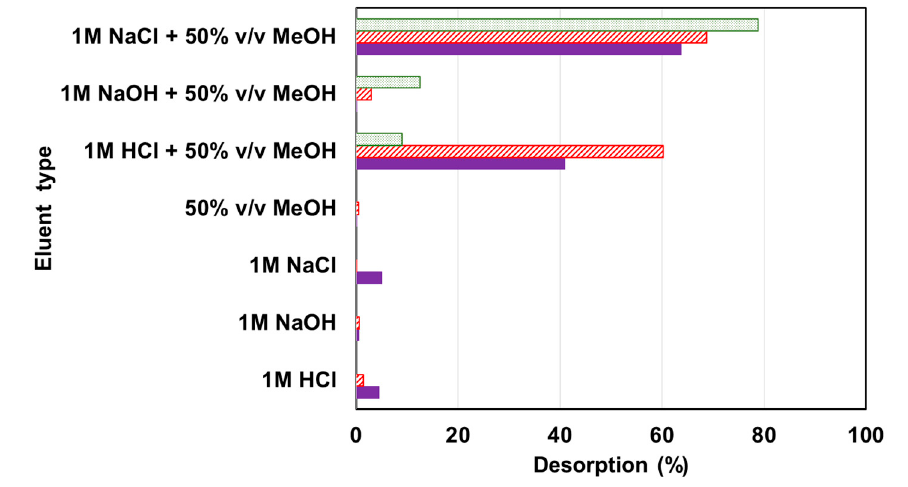
Figure 9. Regeneration of DVB- co -GMA-TETA.